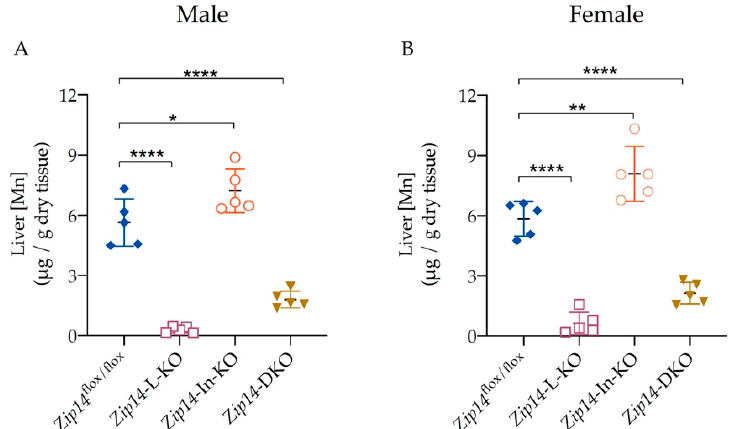
Figure 5. Liver manganese increased in Zip14 -In-KO mice but decreased in both Zip14 -L-KO and Zip14 -DKO mice. Liver Mn contents were measured by ICP-MS in ( A ) male ( n = 5) and ( B ) female mice ( n = 5). Data were expressed as mean ± SD and were subjected to a one-way ANOVA followed by the Bonferroni post-hoc test to compare the mean of each knockout group to the control group. * p < 0.05, ** p < 0.01 and **** p < 0.0001.